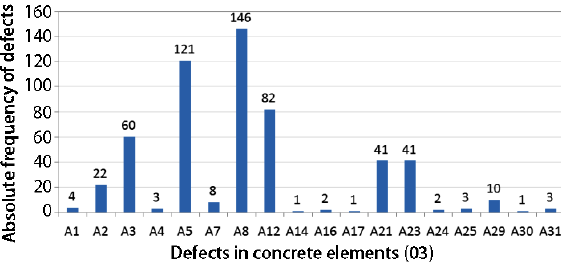
Fig. 11. Absolute frequency of defects according to the construction elements